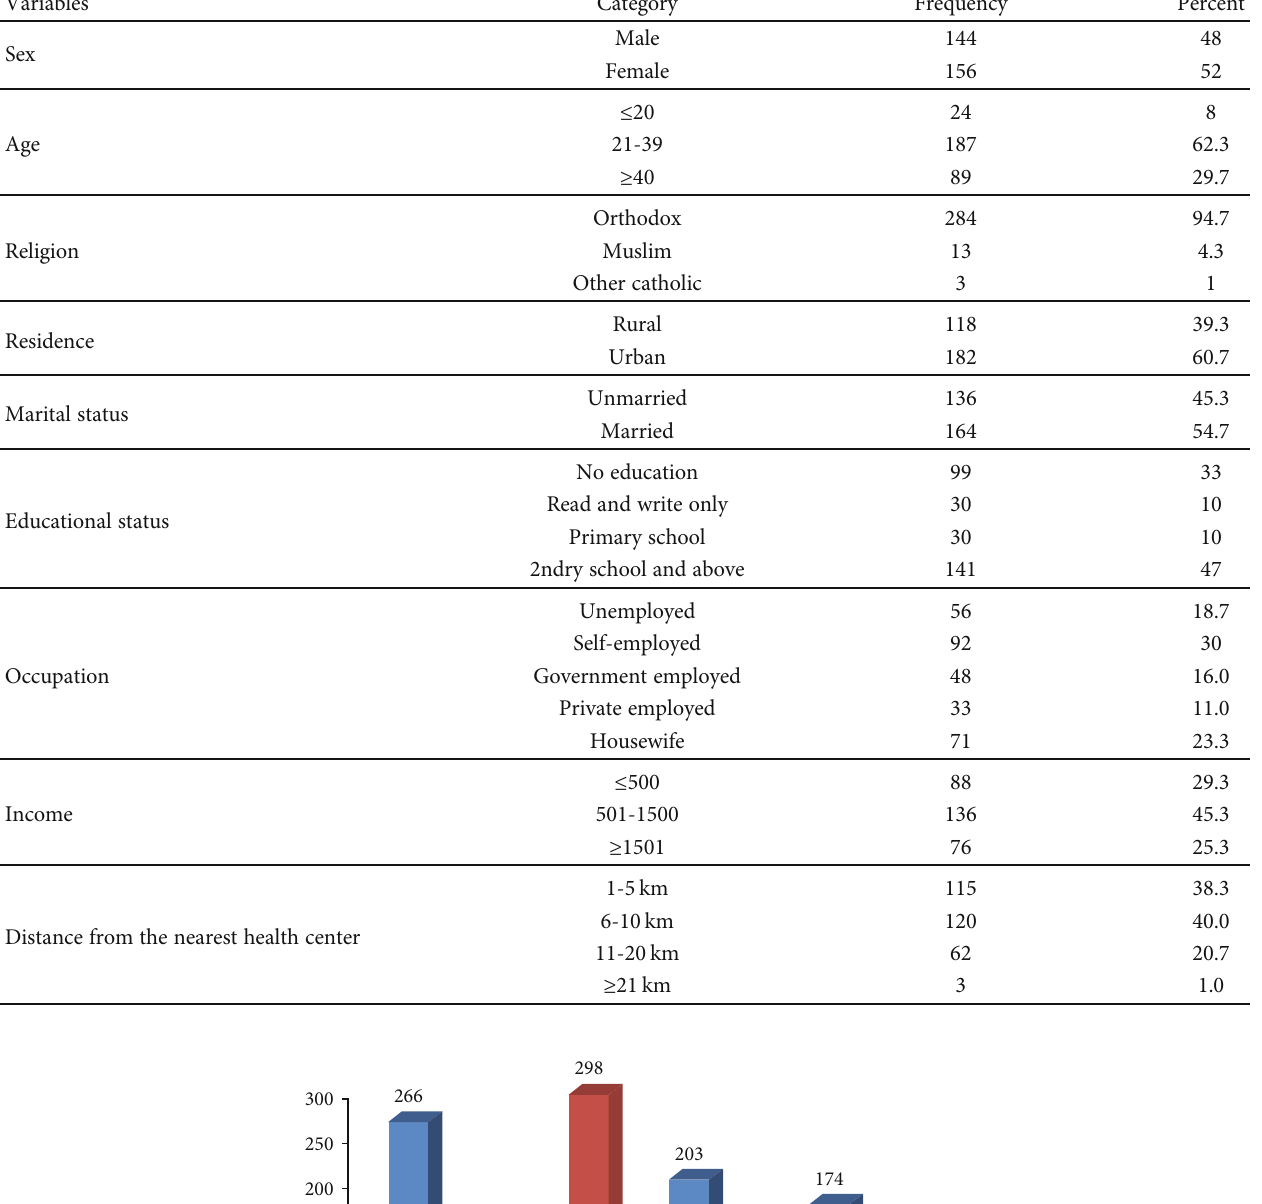
Table 1: Sociodemographic characteristics of tuberculosis patients attending DOTS clinic.